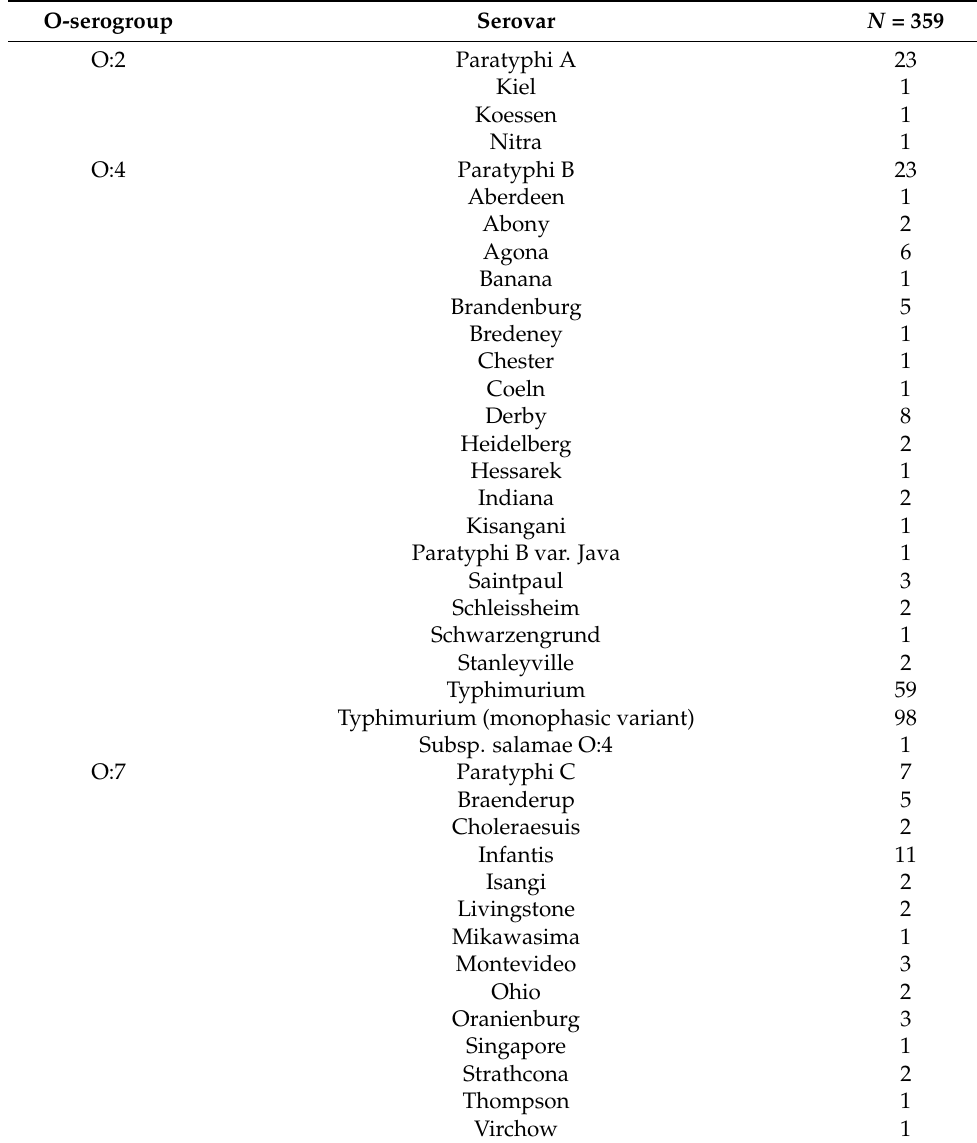
Table 1. Salmonella enterica isolates included in the